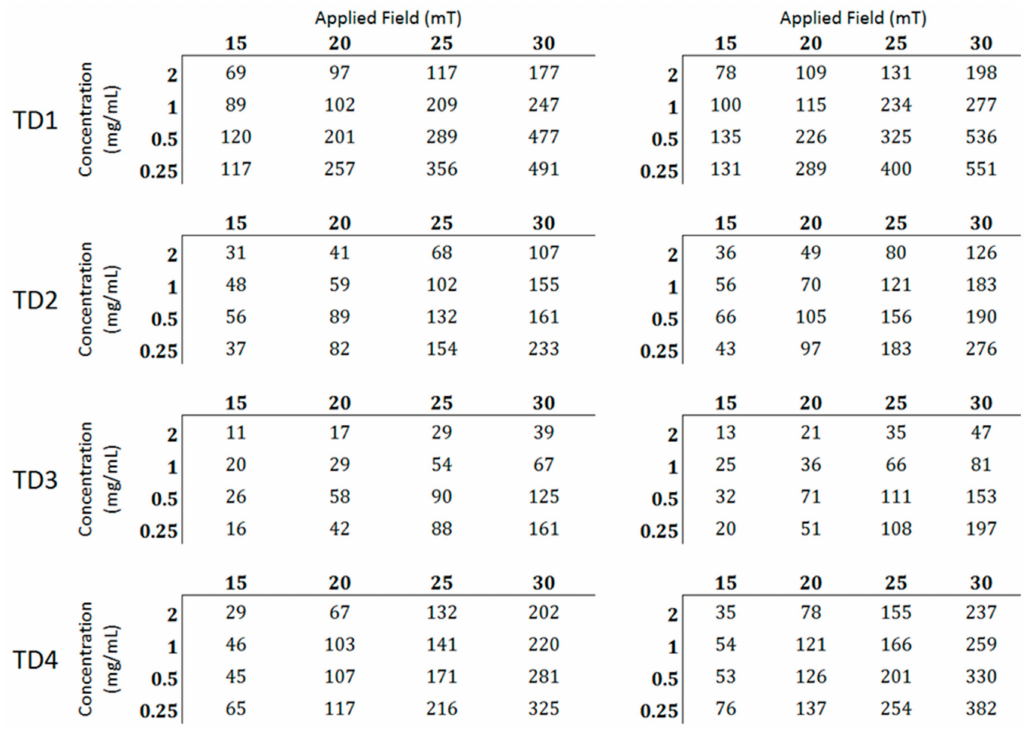
Figure 10. At the left tables the net specific loss power (SLP) values (W / g) per field and concentration are presented. At the right tables the values scaled to the metallic cores are presented.